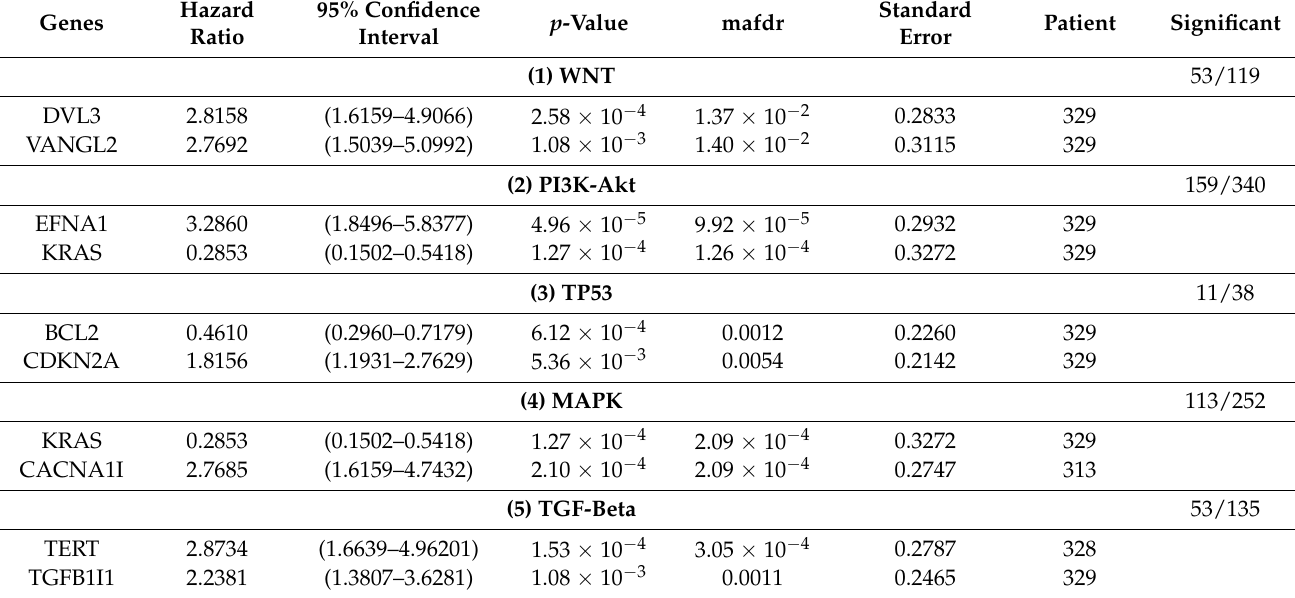
Table 2. The top two significant genes across five CRC relevant signalling pathways from the TCGA Legacy dataset. A Kaplan–Meier estimate and log-rank test were used to compute the association between patient event-free survival and gene expressions. The associated hazard ratio, 95% confidence interval, p -value, mafdr (estimate positive false discovery rate for multiple hypothesis testing), and standard error are apparent. “Patient” indicates the number of patients for which data were available. The last column, “significant”, indicates the number of significant genes out of the total number of genes for this pathway. The fold change and p -value cut-off used were 0.5 and 0.05, respectively.